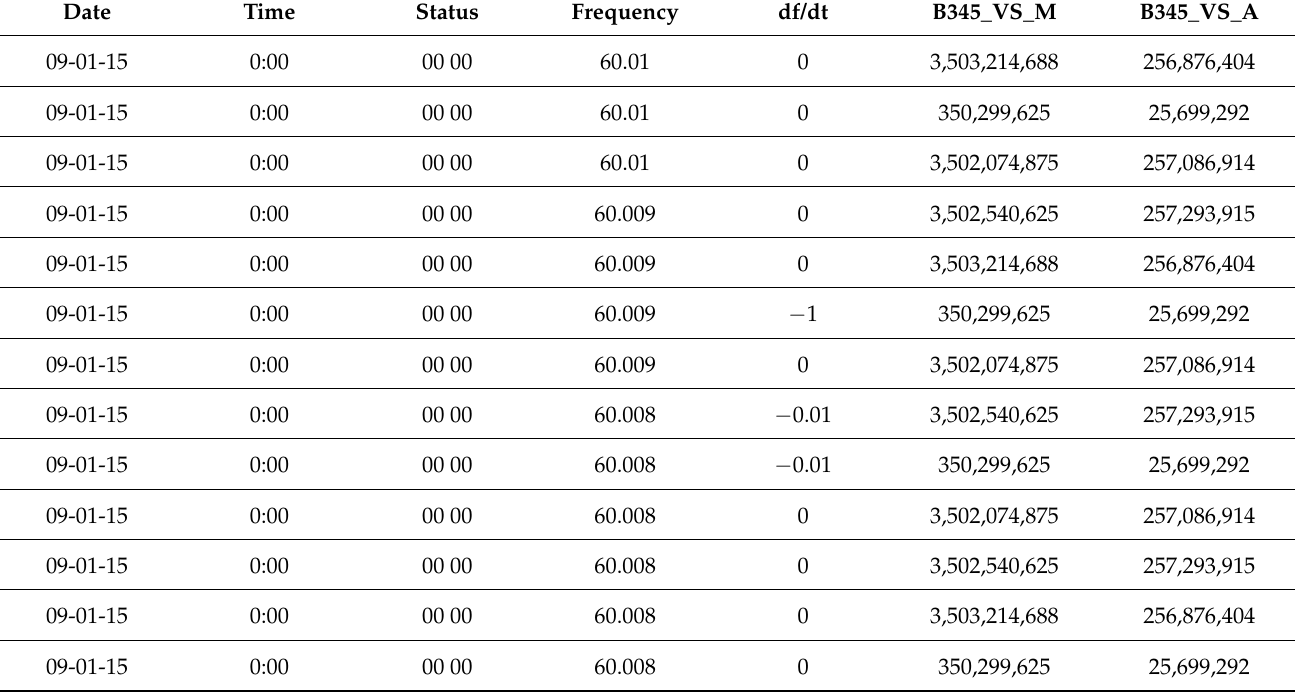
Table 1. The 313 MW Orrington PMU data